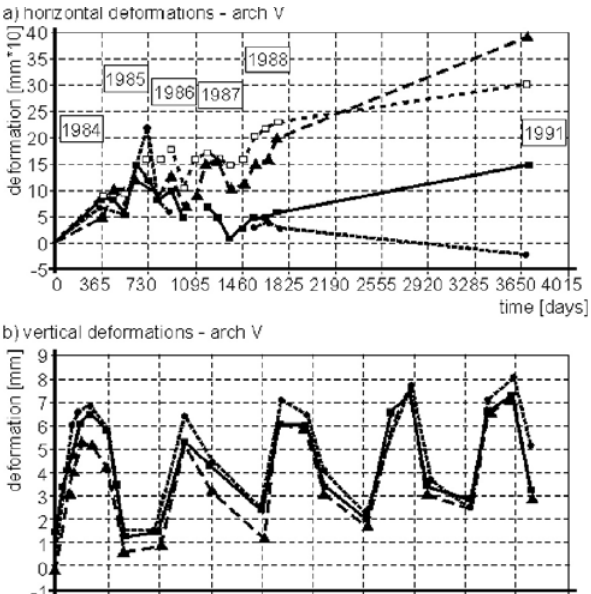
Fig 11. Experimentally measured horizontal deformations of opposite breast walls (a) and vertical deformations of bridge crown sections (b)